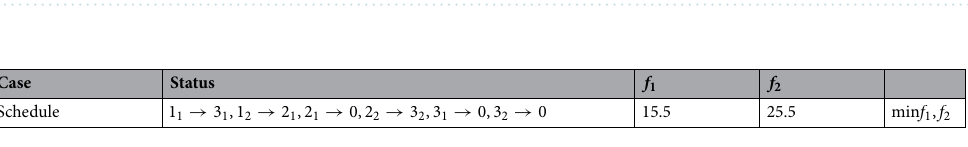
Table 6. Problem solving results in three patients and three